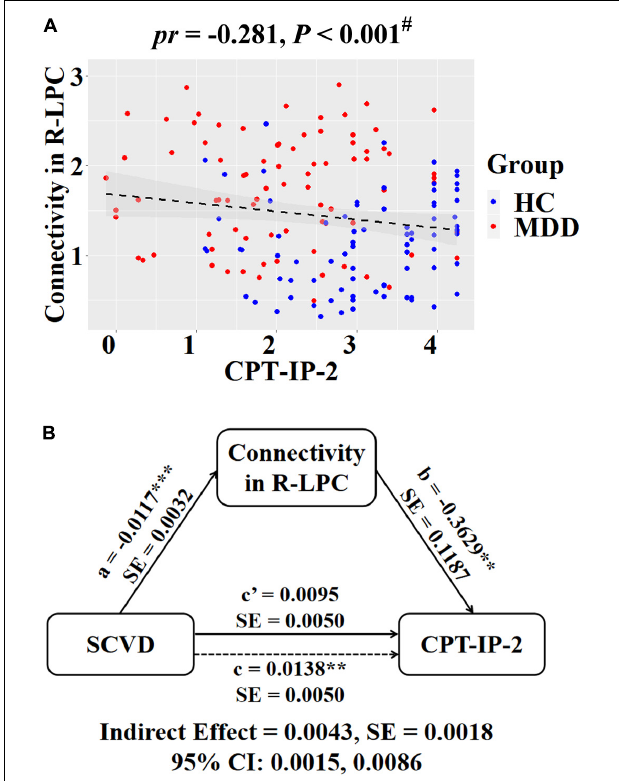
FIGURE 6 | Associations between SCVD, intranetwork functional connectivity, and CPT-IP-2 in females. (A) A scatter plot shows correlation between intranetwork connectivity in the right LPC and CPT-IP-2. (B) Graphical representation of the mediation analysis between SCVD and CPT-IP-2 with intranetwork connectivity in the right LPC as the mediator: estimates of the mediated ( a × b ), direct ( c (cid:48) ), and total ( c ) effects. # P < 0.05, false discovery rate correction for multiple comparisons. ** P < 0.01, *** P < 0.001. SCVD, serum concentration of vitamin D; CPT-IP, Continuous Performance Task-Identical Pairs; LPC, lateral parietal cortex; HC, healthy controls; MDD, major depressive disorder; R, right; pr , partial correlation coefficient; SE, standard error; CI, confidence